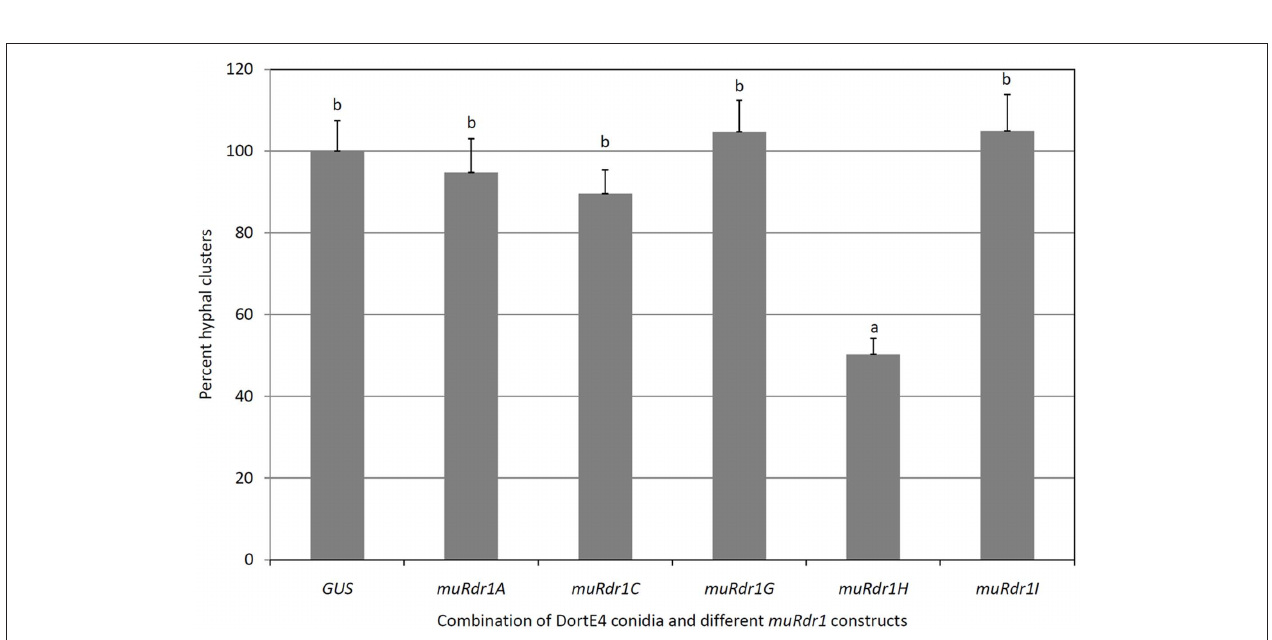
Figure 6 | Transient complementation disease assay with individual muRdr1 TNLs and Dorte4. This graph represents average data of nine independent experiments ± SEM. Highly significant reduction in the percent